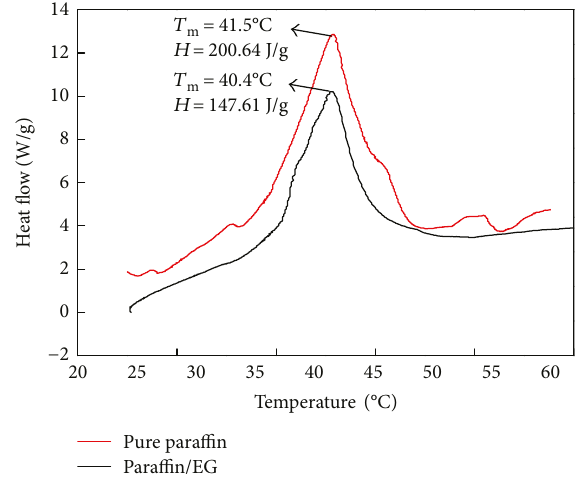
Figure 5: The comparison of latent heat between pure PA and PA/EG composite